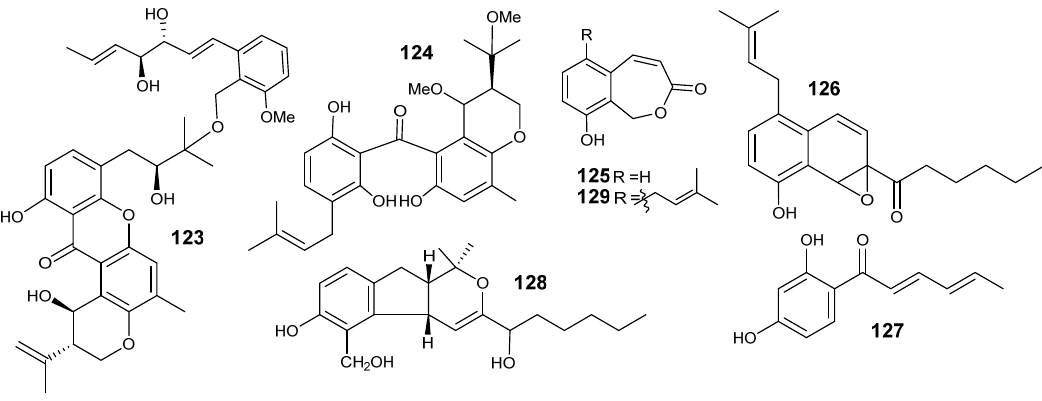
Figure 8. Structures of compounds 123–129.